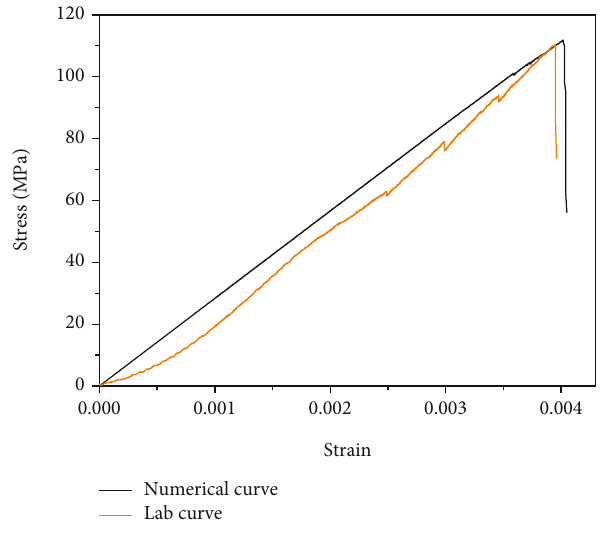
Figure 10: Stress-strain curve.